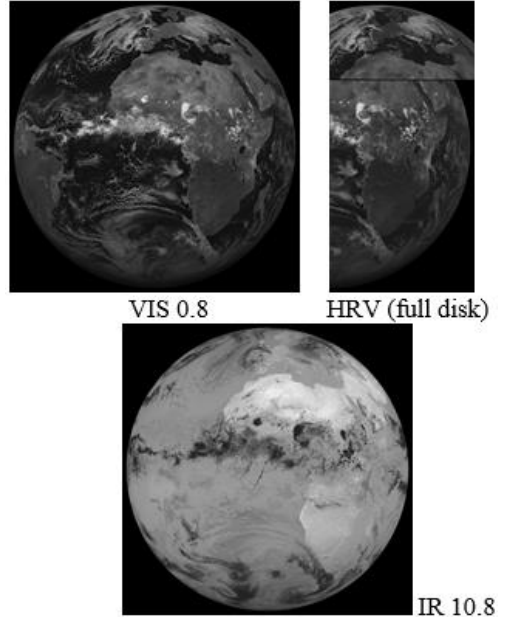
Figure 2. Image examples of HRV (full disk), VIS0.8 and IR10.8 bands acquired on July 1 st , 2018, at 12:00 UTC.